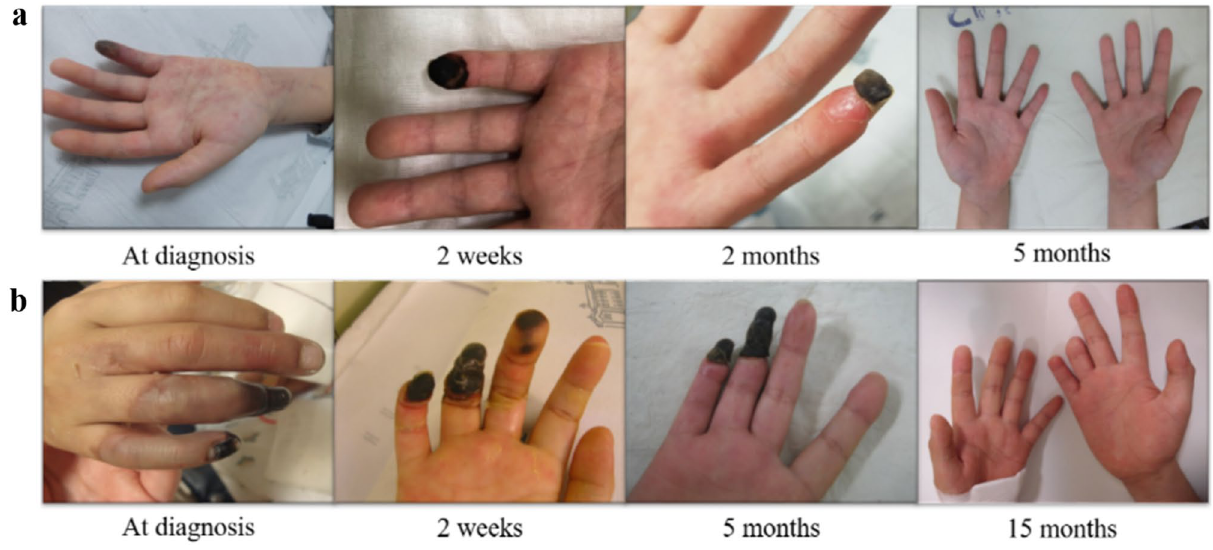
Figure 2. Treatment responses and final outcomes for patients with skin involvement. ( a ) This patient exhibited Raynaud’s phenomenon in the third, fourth, and fifth fingertips as well as skin necrosis in the fifth fingertip at diagnosis. Early diagnosis and aggressive treatment allowed for preservation of the fifth finger despite slight shortening. ( b ) This patient experienced finger pain at the initial visit and gangrene in the third, fourth, and fifth fingers, which worsened during transfer despite corticosteroid treatment. Despite aggressive treatment, amputation of the fourth and fifth fingertips was